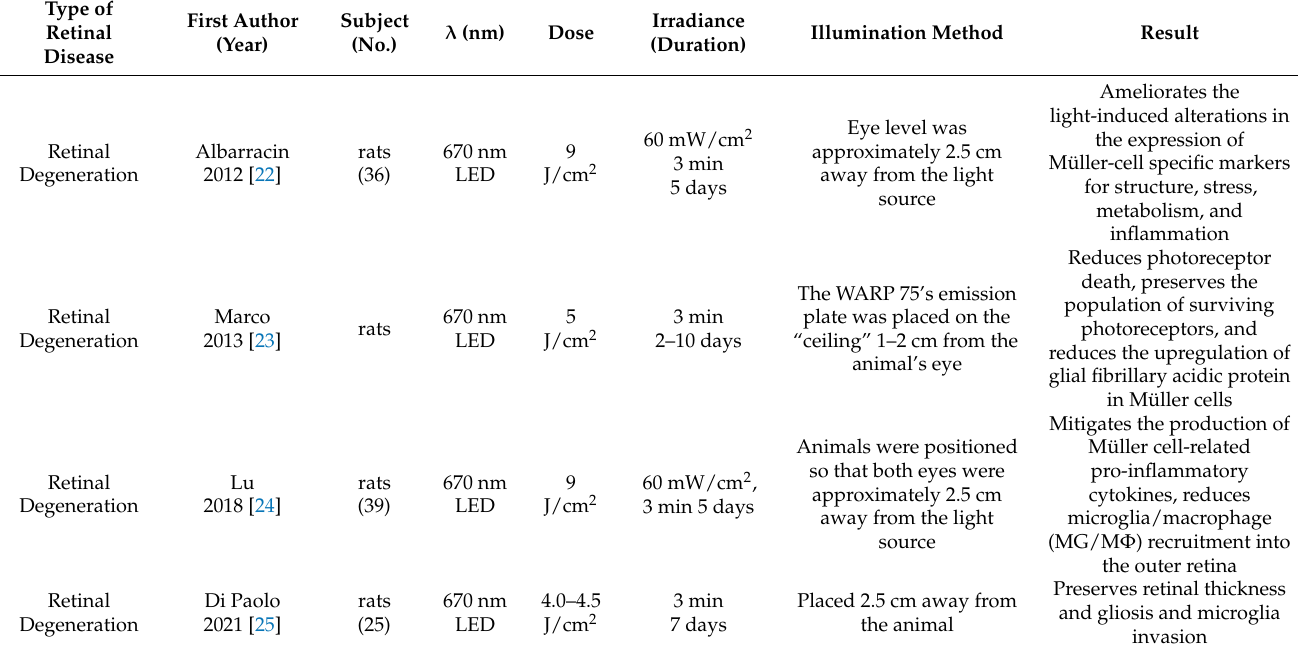
Table 1. Animal studies on PBM for the treatment of retinal